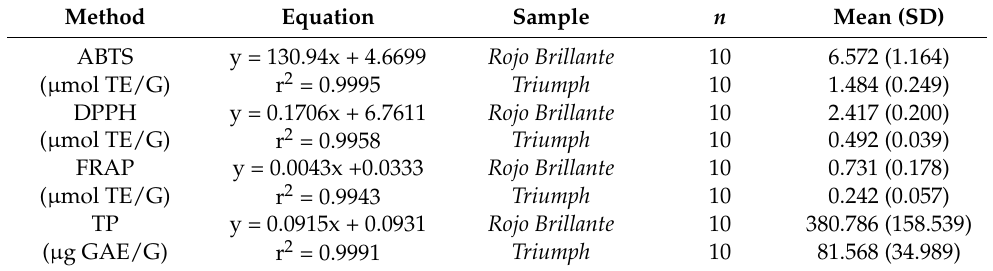
Table 3. Statistical analysis relating to antioxidant activity as measured by DPPH, ABTS, and FRAP assays, and total phenolics as measured by the Folin method in Rojo Brillante and Triumph